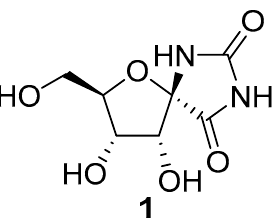
Figure 1. Natural spironucleoside (+)-hydantocidin ( 1 ).